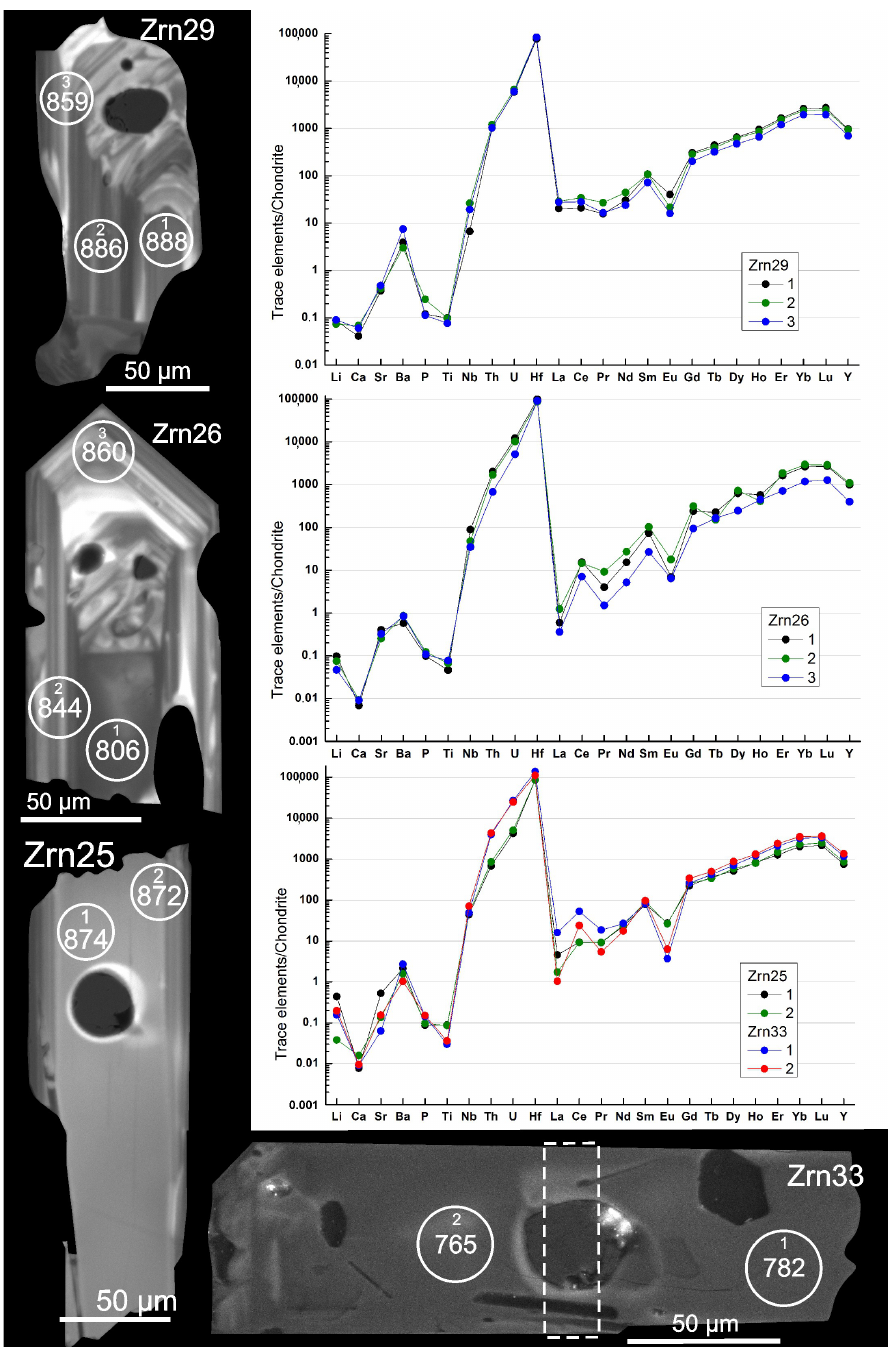
Figure 18. The legend is the same as that presented in Figure 16. The dotted line is the area of analysis used for the LA-ICP-MS method.